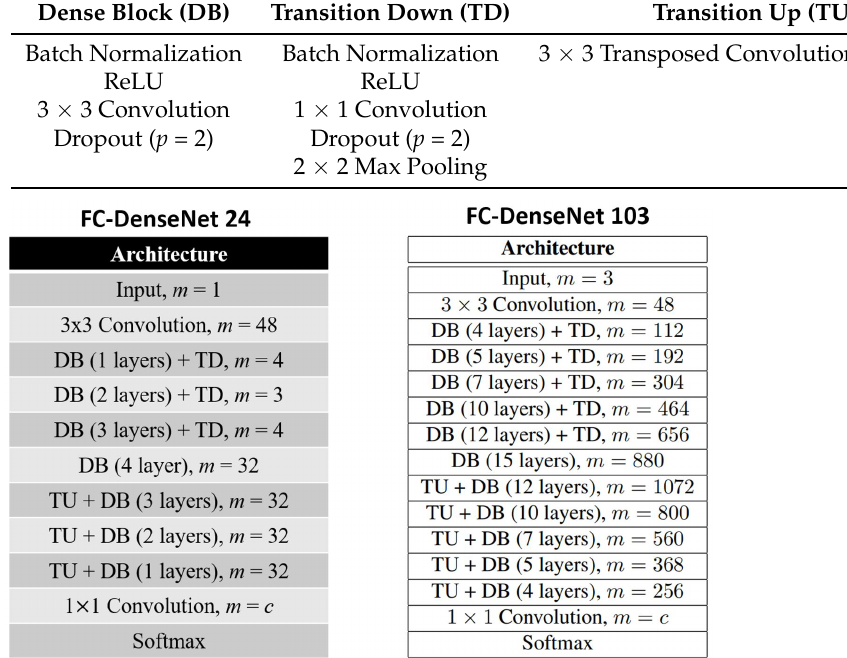
Figure 7. The architectures of the FC-Dense24 and FC-DenseNet103